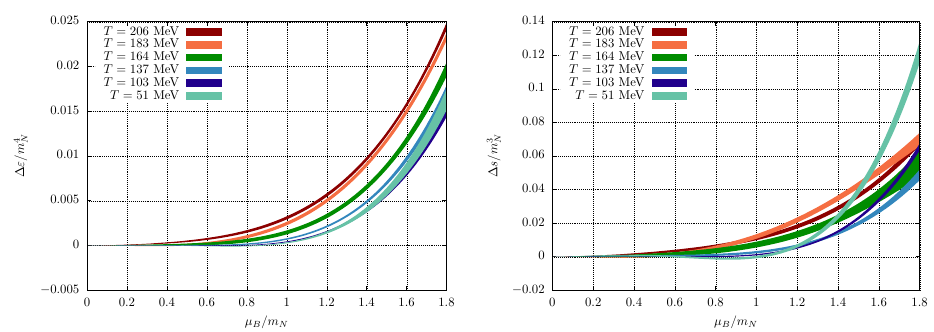
Figure 4: The equation of state extracted from the fermion